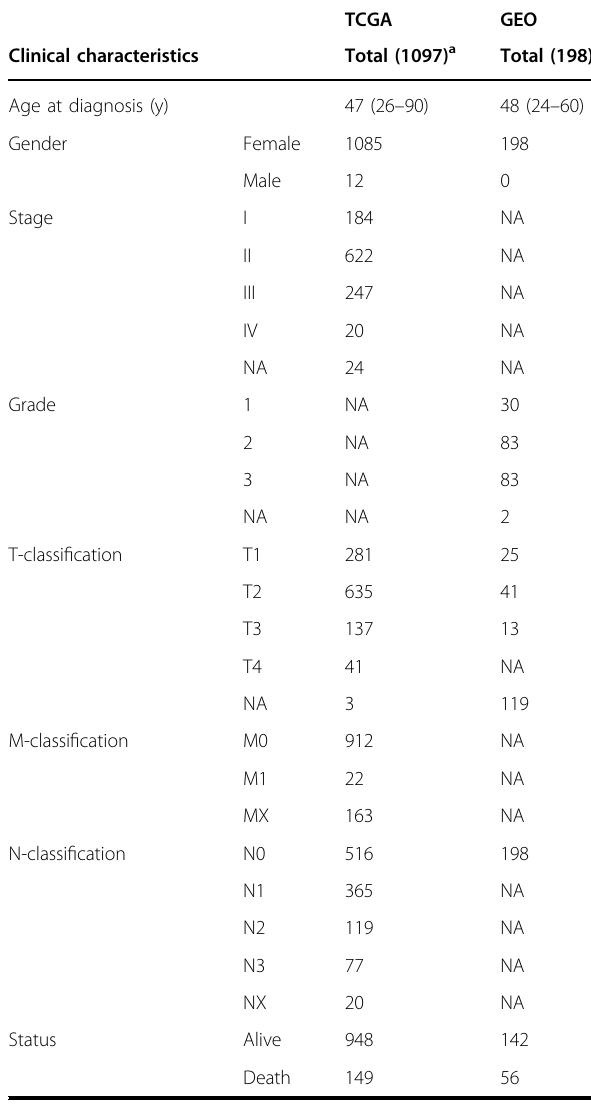
Table 2 TCGA and GEO breast cancer patient